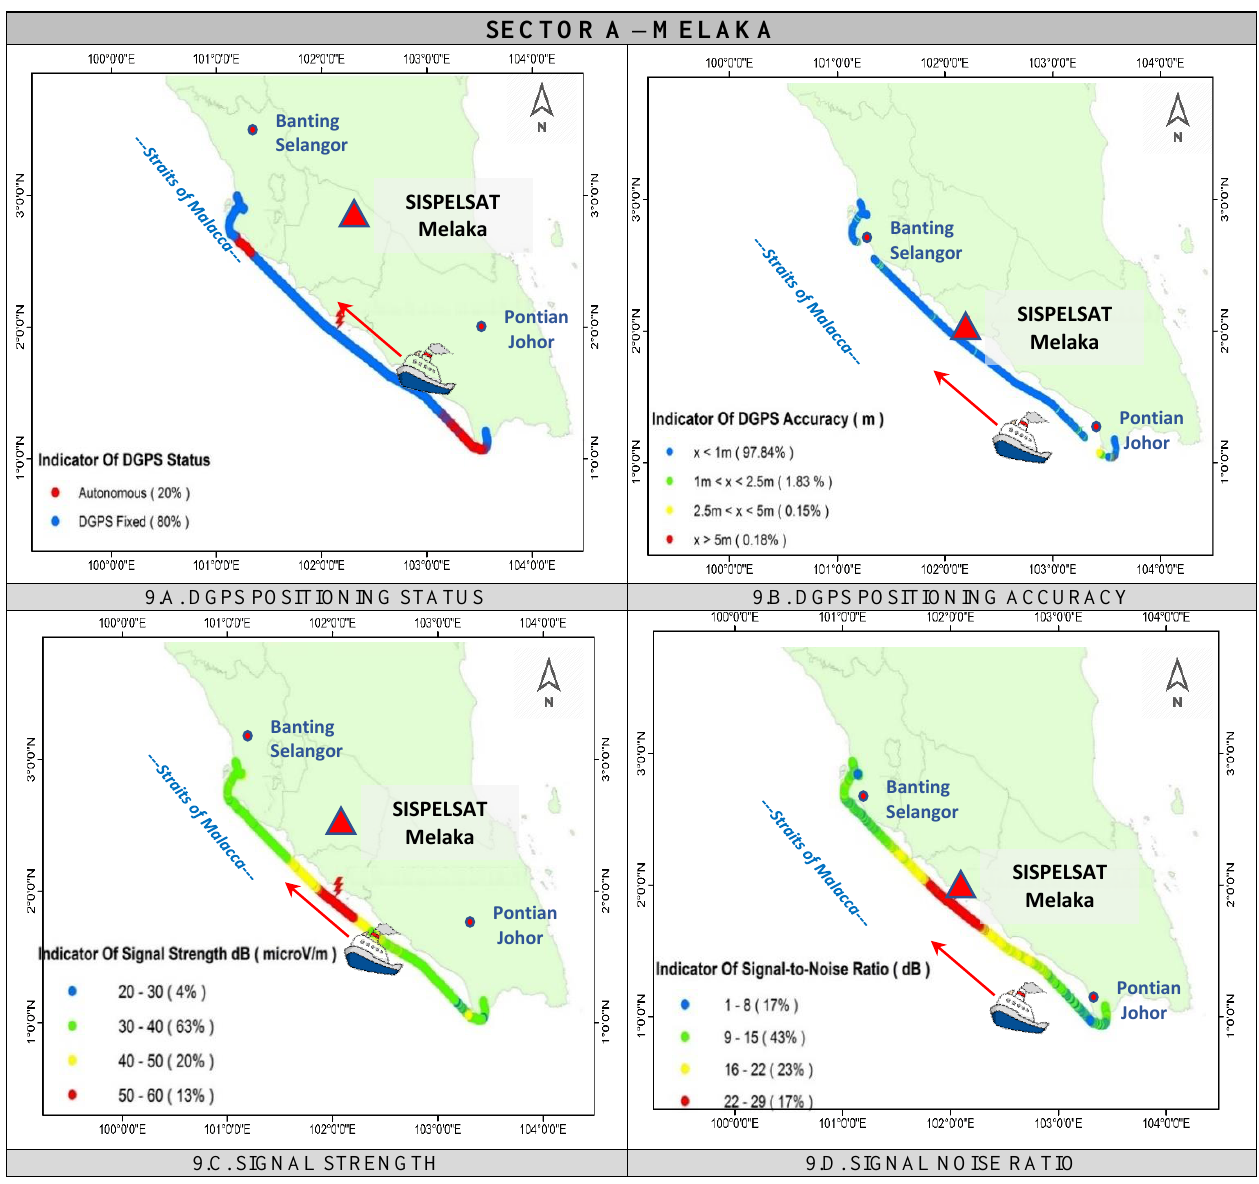
Figure 9. Result map of sector A – SISPELSAT